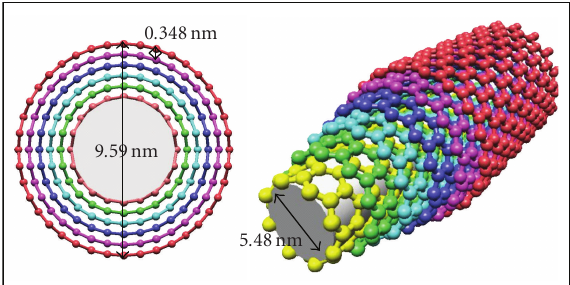
Figure 5: Multiwalled carbon nanotubes.